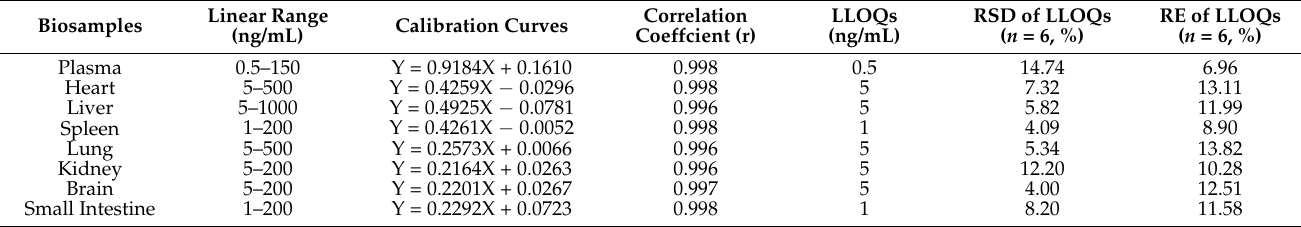
Table 2. Calibration curves of GA in different biological samples.